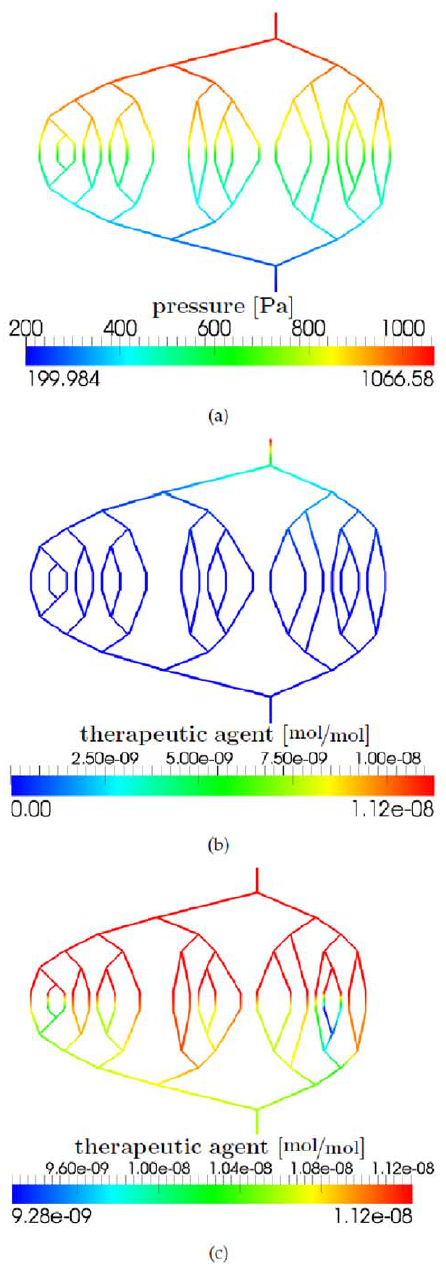
Figure 12. Results of the vascular graph model. (a) Pressure distribution [Pa]. (b) A therapeutic agent is introduced at the arterial root vertex. Drug distribution [ mol = mol ] after one time step. (c) Drug distribution [ mol = mol ] after 11 seconds.